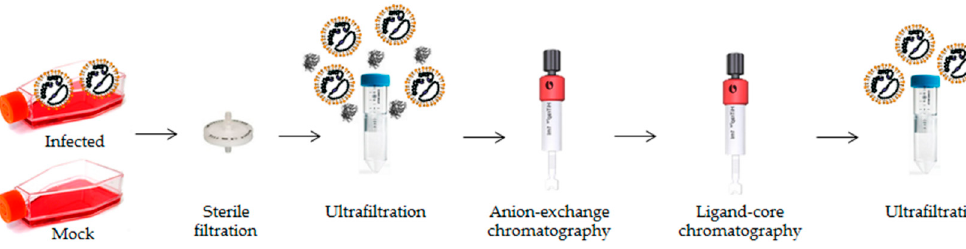
Figure 1. Schematic representation of the flow-through chromatography process used for La Crosse virus (LACV) purification. Mock- and LACV-infected supernatants of VeroE6 cells were purified by sequential steps of ultrafiltration and liquid chromatographic processes to remove host-cell derived proteins (HCPs). At the end of the purification process, a virus enrichment in the LACV sample is attained by efficient removal of HCPs.